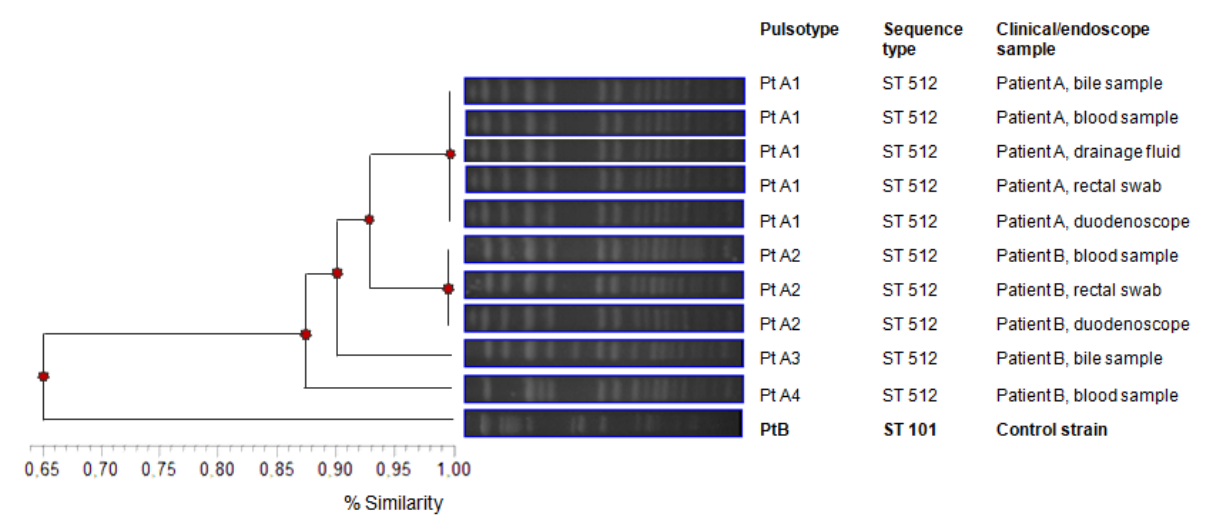
Figure 3. Genotyping of Klebsiella pneumoniae carbapenemase ( KPC )- K. pneumoniae strains isolated from patients and endoscopes. Table 2. High-concern organisms identified during the second phase of microbiological surveillance. Type of Endoscope (Number